Question: Write a single sentence explaining what this figure depicts.
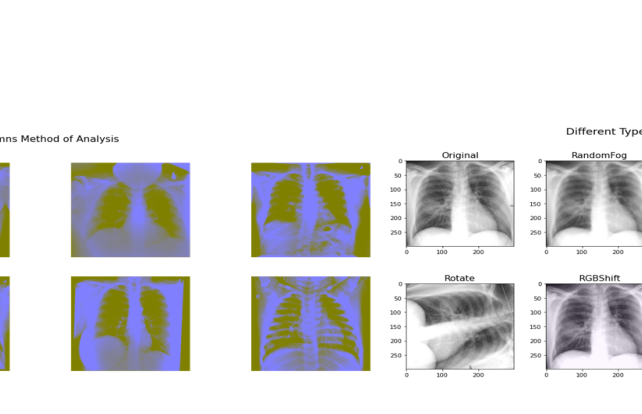
Answer: The Ben Graham Processing and Data Augmentation of the images